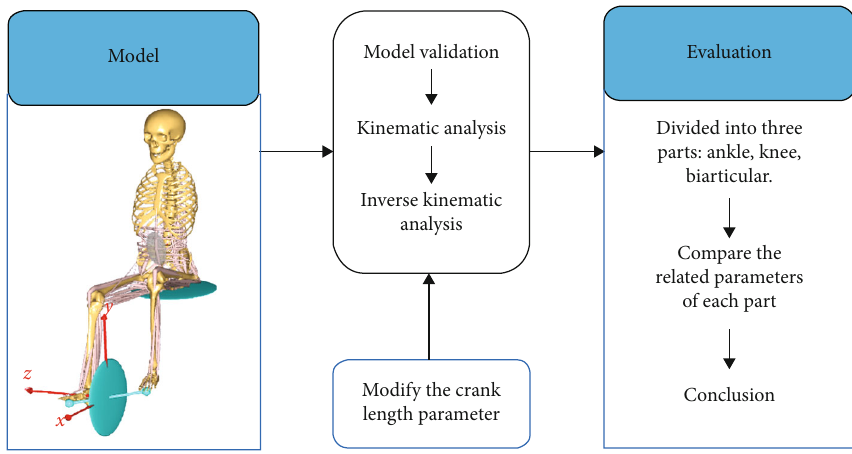
Figure 1: Analysis process of the in fl uence of crank length on muscle behavior during cycling. Table 1: Musculotendon parameters, based on and adapted from Ward et al. [28] and Millard et al.